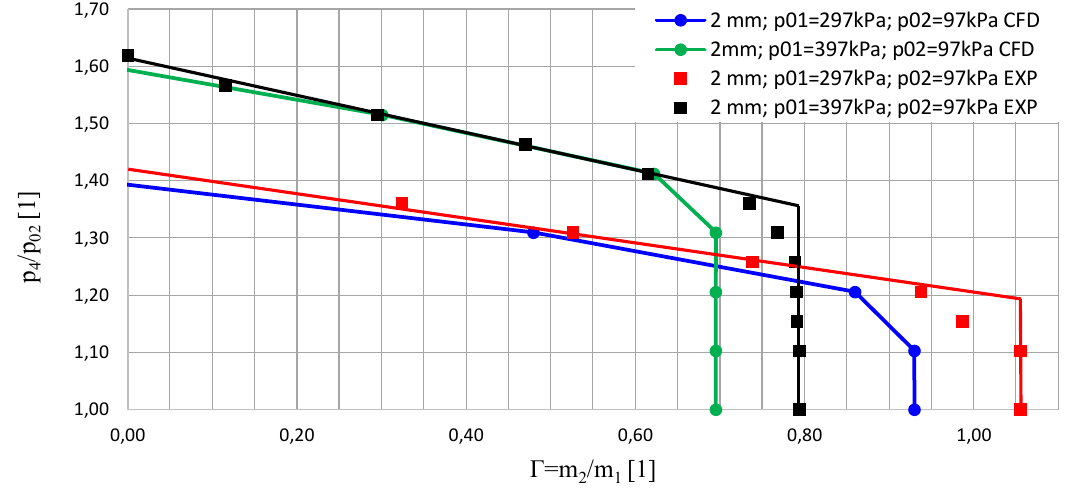
Fig. 11. Characteristic of ejector for NP 2 mm, CFD and experiment for constant secondary pressure